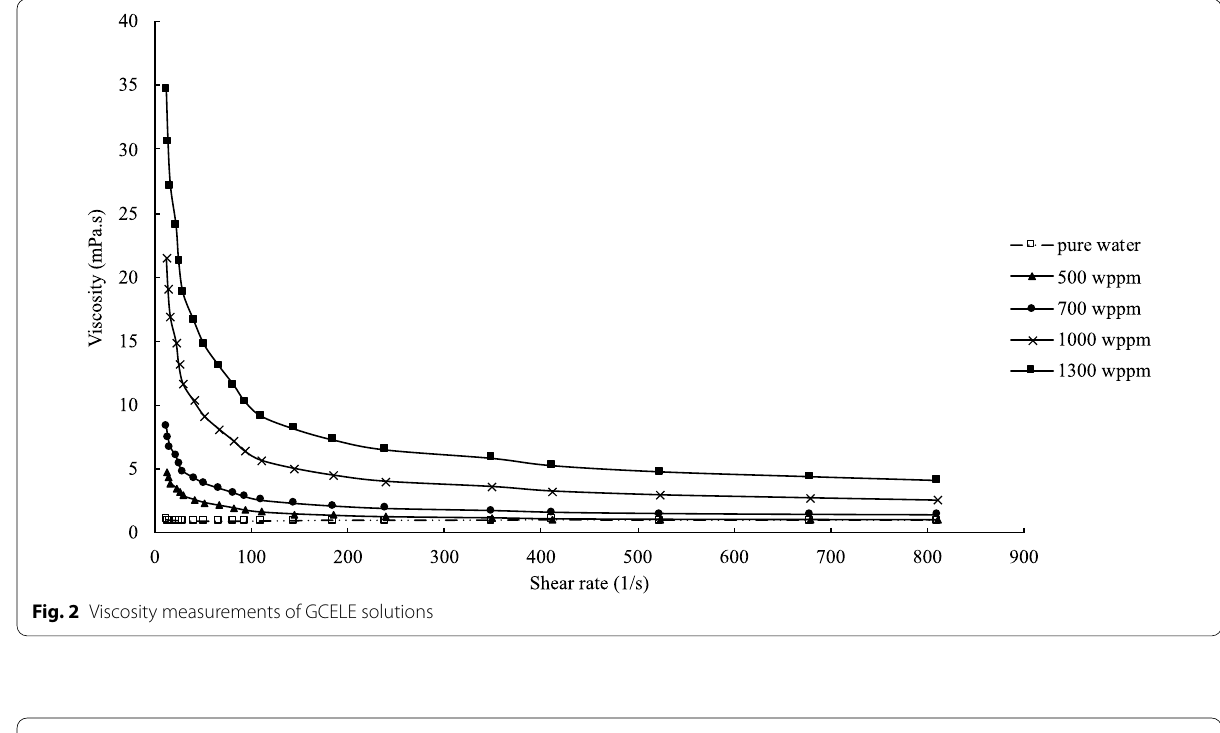
Fig. 2 Viscosity measurements of GCELE solutions